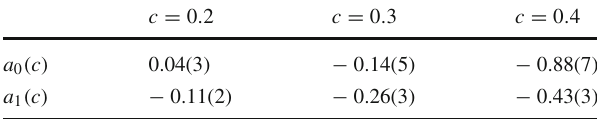
Table 4 Values of the fit coefficients a 0 ( c ) and a 1 ( c ) that parameterize the sensitivity of ¯ g 2 c to the boundary improvement coefficient c